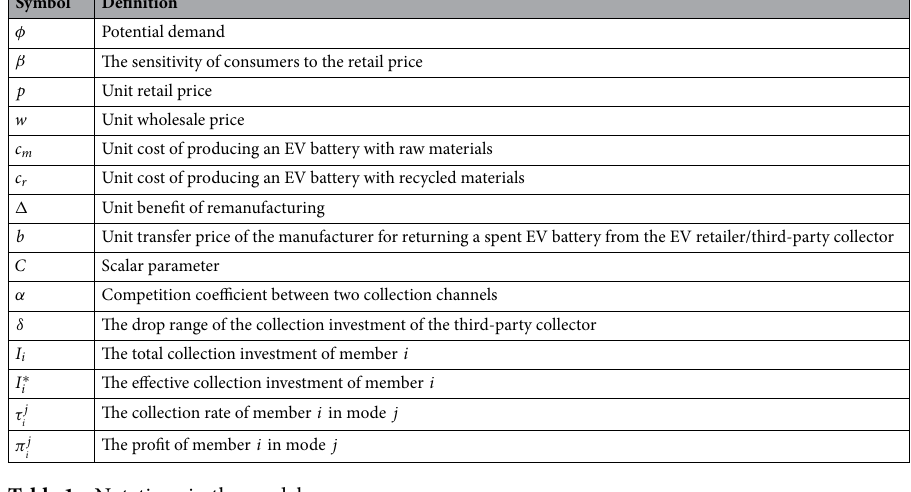
Table 1. Notations in the